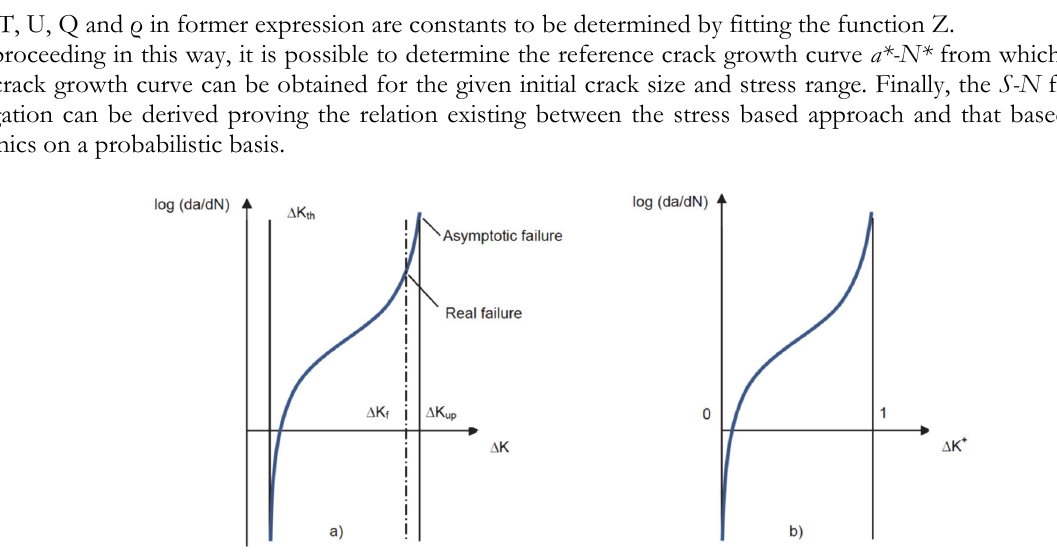
Figure 5: a) Original and b) normalized crack growth rate [7].